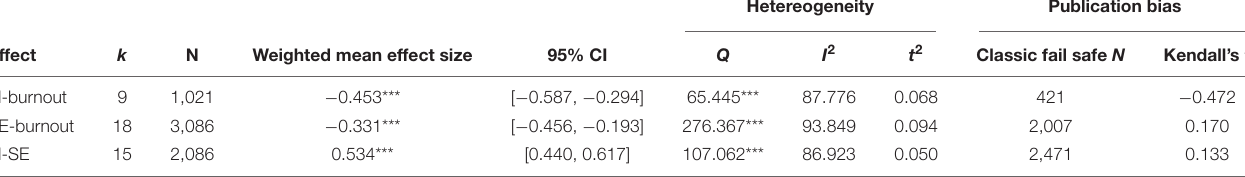
TABLE 2 | Summary of weighted effect